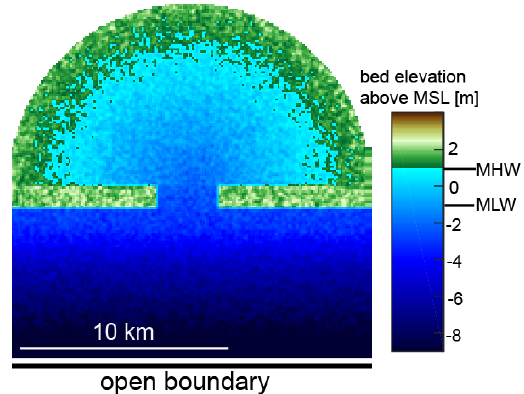
Figure 3. Initial model bathymetry and boundary conditions.